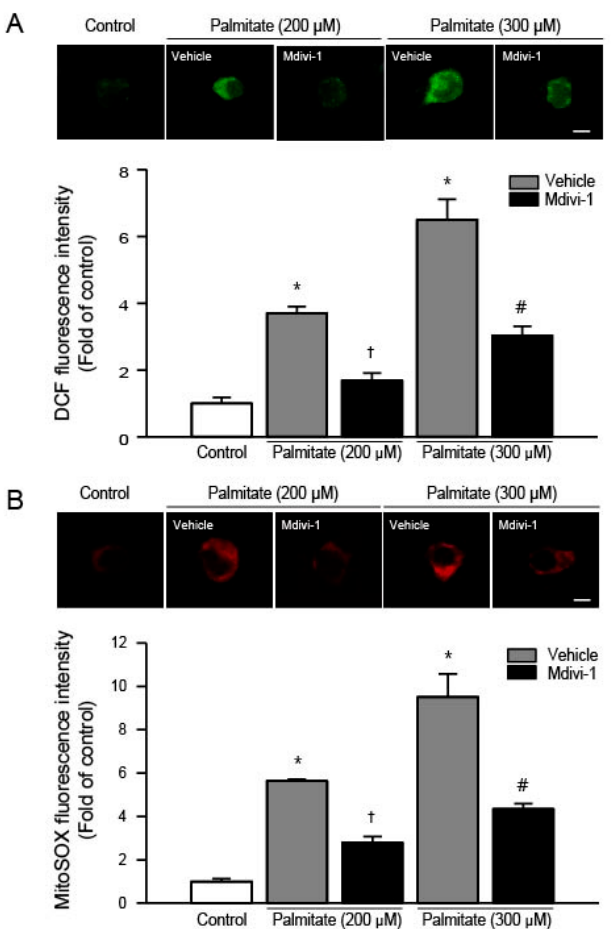
Figure 3. Effect of mdivi-1 on the intracellular and mitochondrial ROS production in hippocampal NSCs exposed to palmitate insult. Cells were pretreated with DMSO vehicle or mdivi-1 (20 μ M) for 2 h and then exposed to 0.5% BSA vehicle or palmitate (200 and 300 μ M) for 24 h. ( A ) Intracellular ROS levels were determined using confocal microscopy on cells stained with the ROS-sensitive fluorescent dye 2’,7’–dichlorofluorescin diacetate (DCFDA). Representative microscopic images show DCFDA-stained hippocampal NSCs (upper panel). Scale bar = 5 μ m. Quantitative analysis (lower panel) showed that DCF fluorescence was increased by palmitate exposure, whereas mdivi-1 inhibited palmitate-induced increase in DCF fluorescence. ( B ) Mitochondrial ROS levels were determined using confocal microscopy on cells stained with the mitochondrial superoxide indicator MitoSOX Red. Representative microscopic images show MitoSOX Red-stained hippocampal NSCs (upper panel). Scale bar = 5 μ m. Quantitative analysis (lower panel) showed that MitoSOX Red fluorescence was increased by palmitate exposure, whereas mdivi-1 inhibited palmitate-induced increase in MitoSOX Red fluorescence. Values are the mean ± SEM of four separate experiments performed in triplicate. * p < 0.05 vs. DMSO-treated control; † p < 0.05 vs. 200 μ M palmitate; # p < 0.05 vs. 300 μ M palmitate.